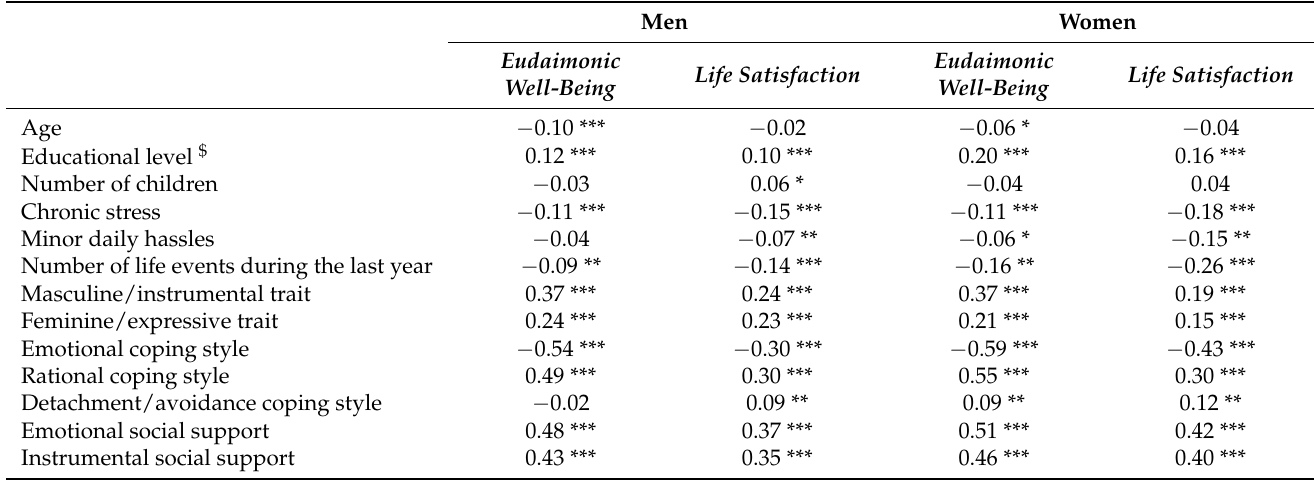
Table 3. Correlations of study variables with eudaimonic well-being and life satisfaction for men and women. Men Women Eudaimonic Eudaimonic Life Satisfaction Life Well-Being Well-Being